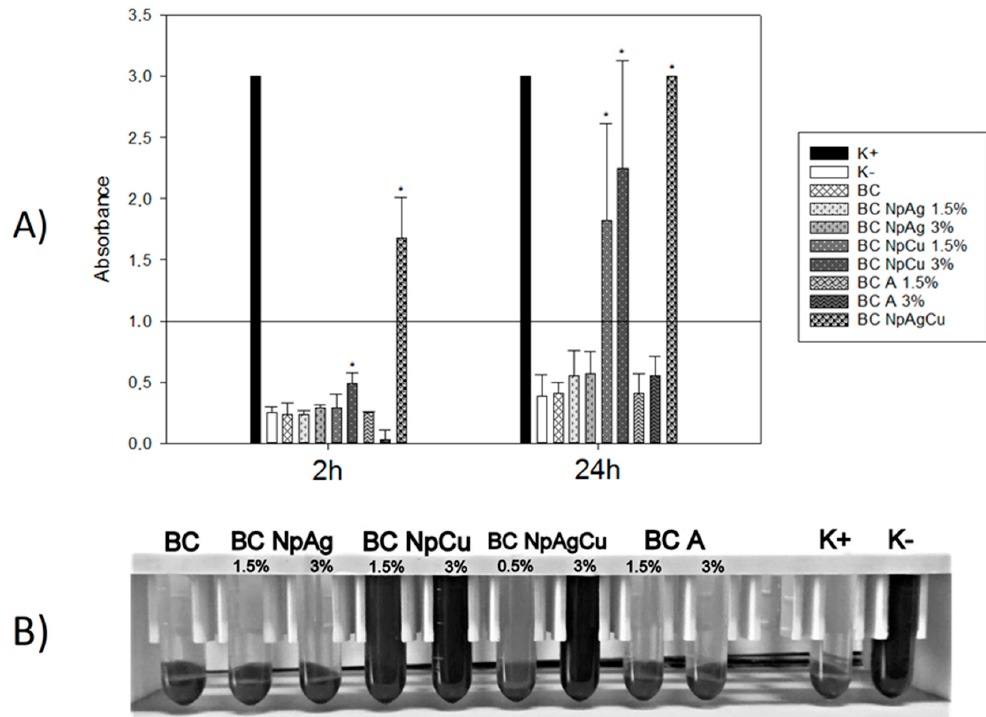
Figure 3. Erythrocyte hemolysis after in vitro exposure to unmodified and modified cement specimens: ( A ) Hemolysis at 2 h and 24 h incubation of materials with erythrocytes—the line indicates the threshold value above which the hemolysis take place (n = 5; data are the means ± SD; * significantly different from negative control— p < 0.05); ( B ) Hemolysis after 24 h incubation of specimens with erythrocytes (the presented pictures are representative for 5 experiments).